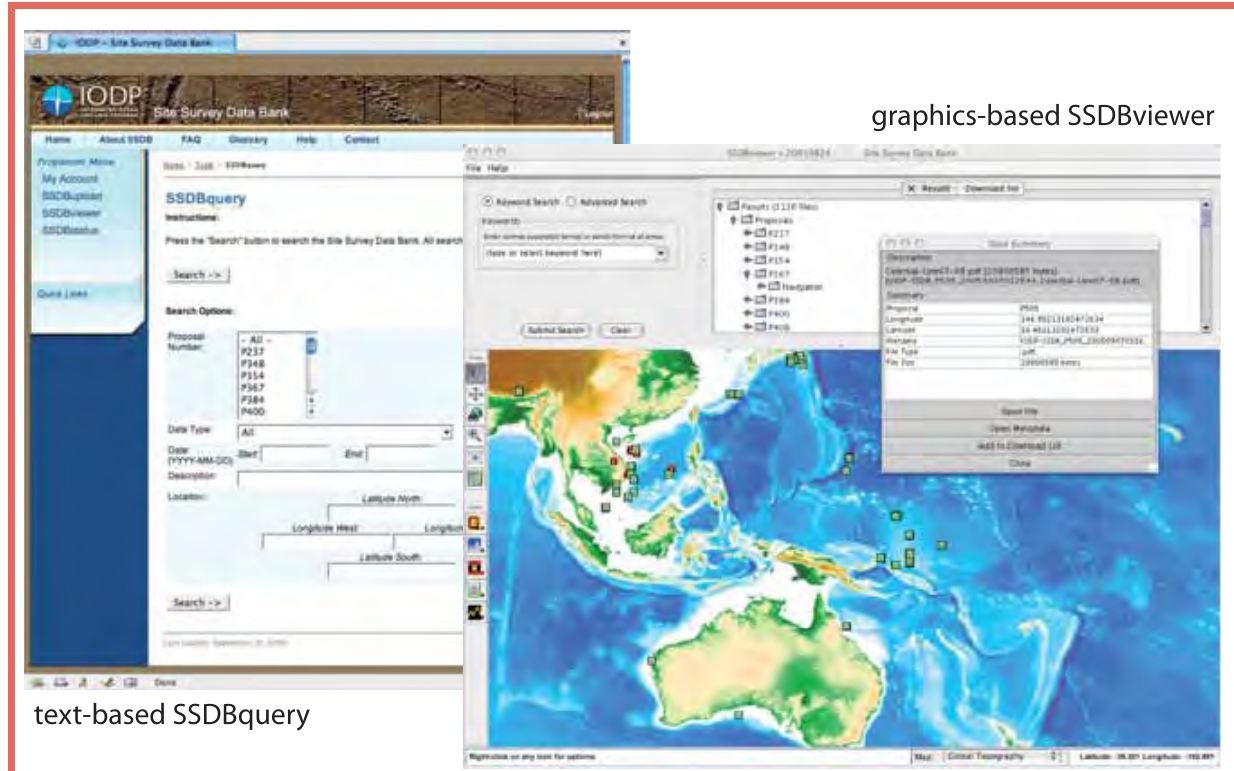
Figure 1. During 2005 a total of 64 proposals have become available online in the SSDB Digital Library, including 3136 spatially referenced digital objects. Data may be discovered by searching for speci fi c data types, proposal number, geographic coordinates, keyword, and other criteria, using either SSDBquery (left image) or SSDBviewer (right image). With SSDBviewer, users may pan around or zoom in on the displayed icons which meet their search criteria, and then open a ‘Data Summary’ panel. From this panel they may then choose to open the fi le and display its contents on screen, view associated metadata, or download the fi le pair to a